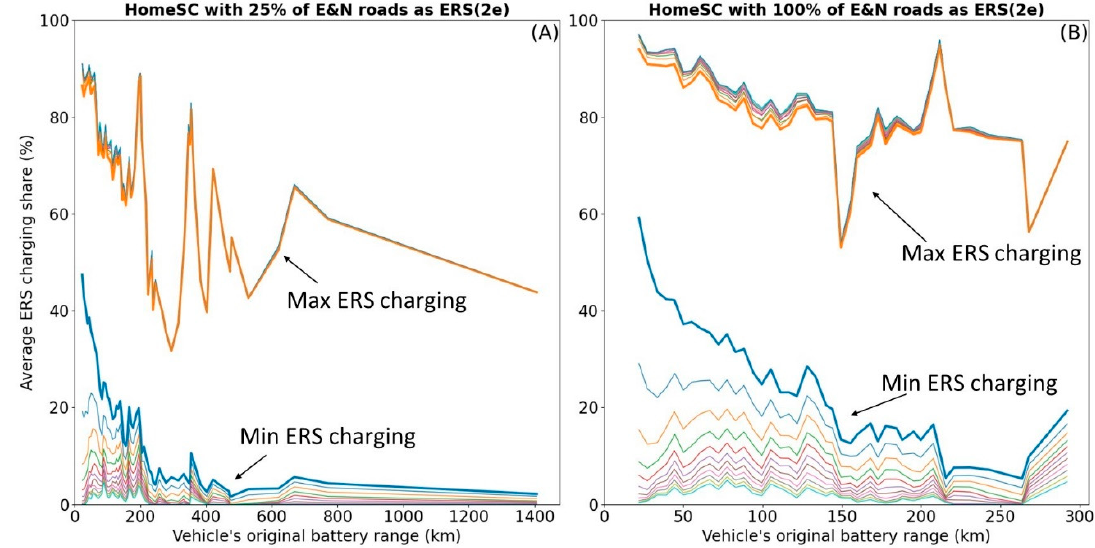
Figure 8. Maximum (thick orange) and minimum (thick blue) average ERS charging shares by min- imum vehicle battery ranges given ( A ) E and N25 and ( B ) E and N100 and for home stationary charging (HomeSC) scenarios. The effects of increased battery ranges beyond the minimum battery requirement are shown in differently colored thin curves in steps of 28 km (i.e., of 5 kWh at e = 0.18